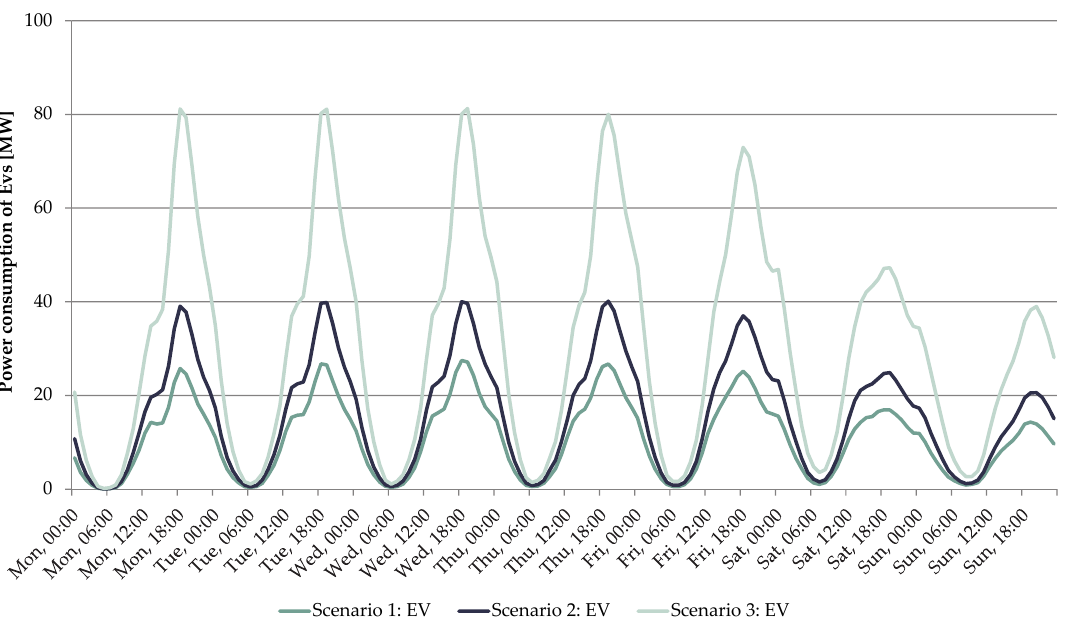
Figure 3. Temporal resolution of the electrical power demand in the model region by EREV and BEV usage for the three